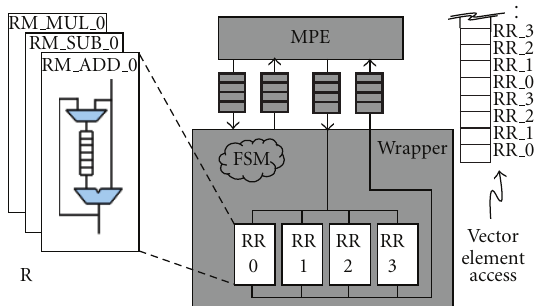
Figure 10: Vector Engine with 4 functional units (RRs) and three